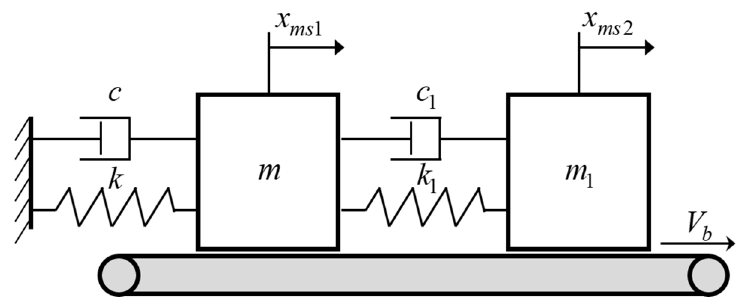
Figure 3. Multi-mode squeak model.